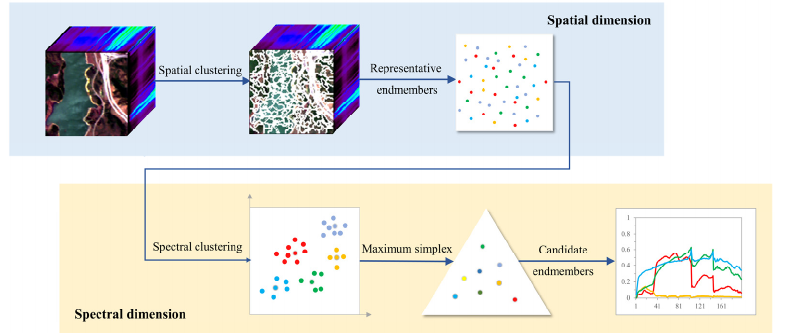
Figure 1. The flowchart of CSVM algorithm.